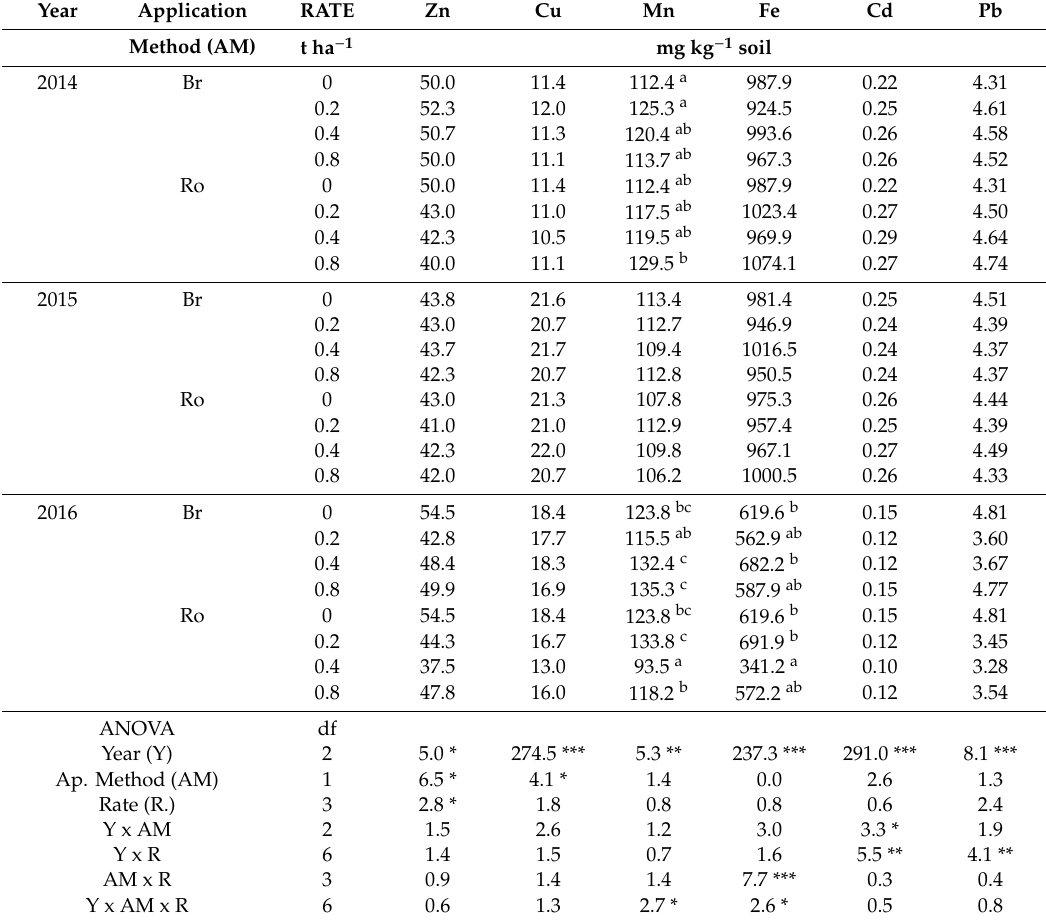
Table 5. E ff ect of digestate application method and rate on soil pH, content of inorganic nitrogen and plant-available micronutrients and trace